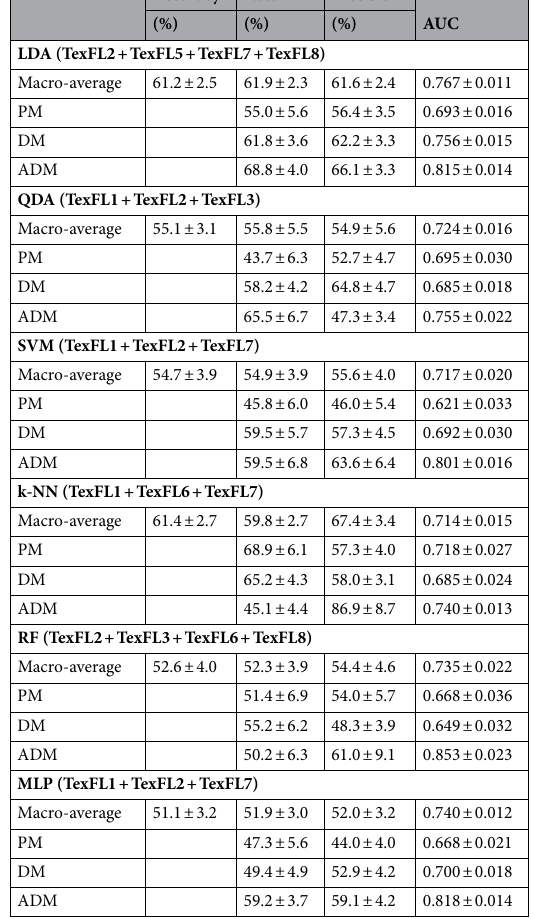
Table 4. Performance of multi-class classifications of IIM groups (LBP features). Note Data are means ± standard deviations. Feature name codes are as follows: TexFL1 = total energy, TexFL2 = variance, TexFL3 = cluster shade, TexFL4 = contrast, TexFL5 = difference entropy, TexFL6 = long run emphasis, TexFL7 = long run low gray-level emphasis, TexFL8 = gray-level non-uniformity, TexFL9 = busyness. LDA linear discriminant analysis, QDA quadratic discriminant analysis, SVM support vector machine, k-NN k-nearest neighbors classifier, RF random forest classifier, MLP multi-layer